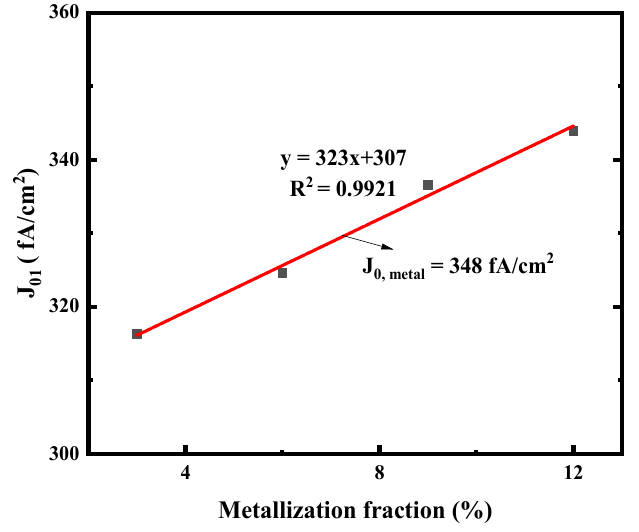
Figure 17. J 01 extracted from Suns-V OC as a function of metal fraction variation on the cell boron emitter. The J 0, metal is then extracted from the linear fit (solid lines).